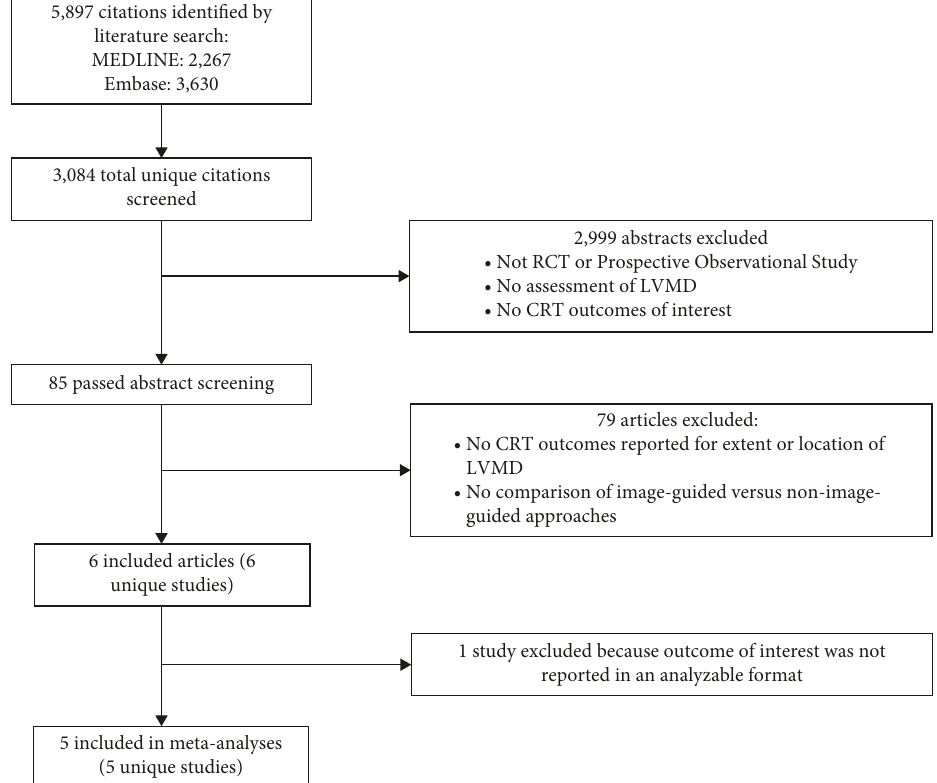
Figure 1: Literature flow diagram. CRT � cardiac resynchronization therapy; LVMD � left ventricular mechanical dyssynchrony; RCT � randomized controlled